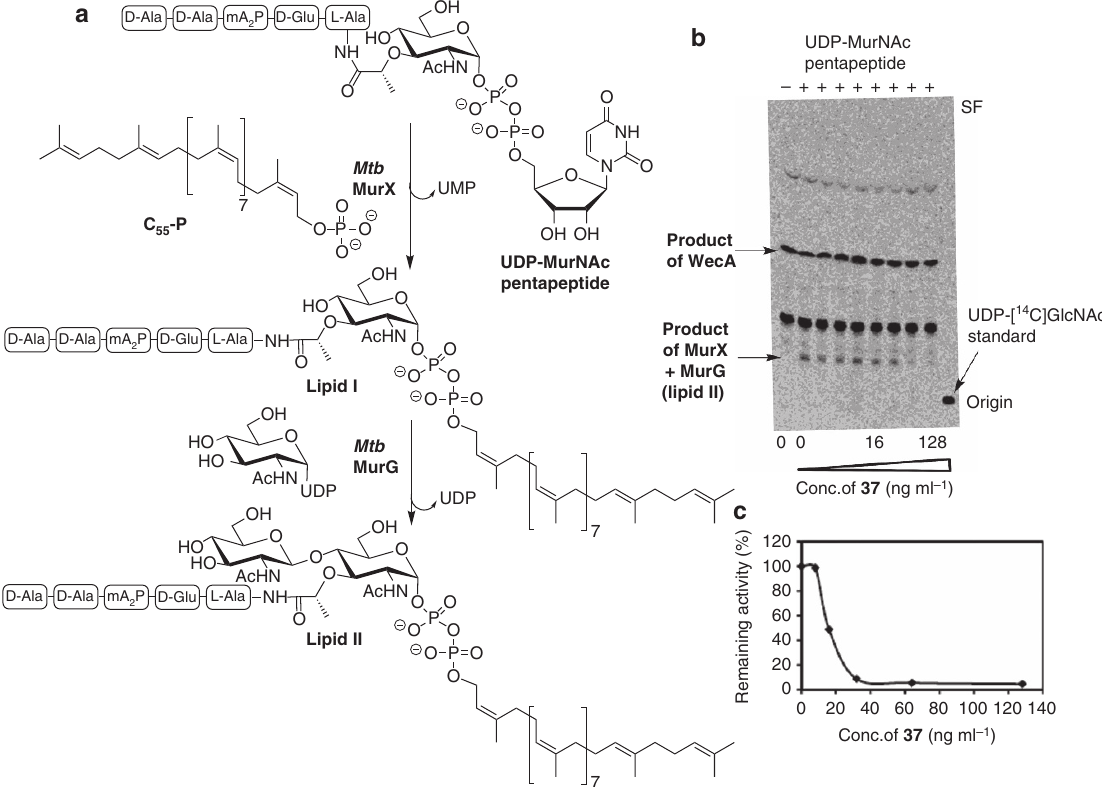
Figure 4 | Inhibition studies of the synthetic sansanmycin analogues against Mtb MurX. ( a ) Reactions catalysed by Mtb MurX to generate lipid I and Mtb MurG to generate lipid II. ( b ) Exemplar TLC assay from Mtb mc 2 6230 membranes for the inhibition of Mtb MurX–MurG by dihydrosansanmycin analogue 37 (IC 50 ¼ 41nM). Positive control ¼ pacidamycin D 19 and tunicamycin. Ala, alanine; Glu, glutamate; mA 2 P, meso -diaminopimelic acid. Product of MurX ¼ decaprenyldiphosphoryl-MurNAc-pentapeptide (lipid I), product of MurG ¼ decaprenyldiphosphoryl-MurNAc-pentapeptide-GlcNAc (lipid II), product of WecA ¼ decaprenyldiphosphoryl-GlcNAc. ( c ) Inhibition assay of Mtb MurX with dihydrosansanmycin analogue 37 (IC 50 ¼ 16nM) using dansylated UDP-MurNAc pentapeptide as substrate. K m(app) UDP-MurNAc-pentapeptide ¼ 51 ± 4 m M and V max(app) ¼ 69 ± 1.9 m Mmin (cid:2) 1